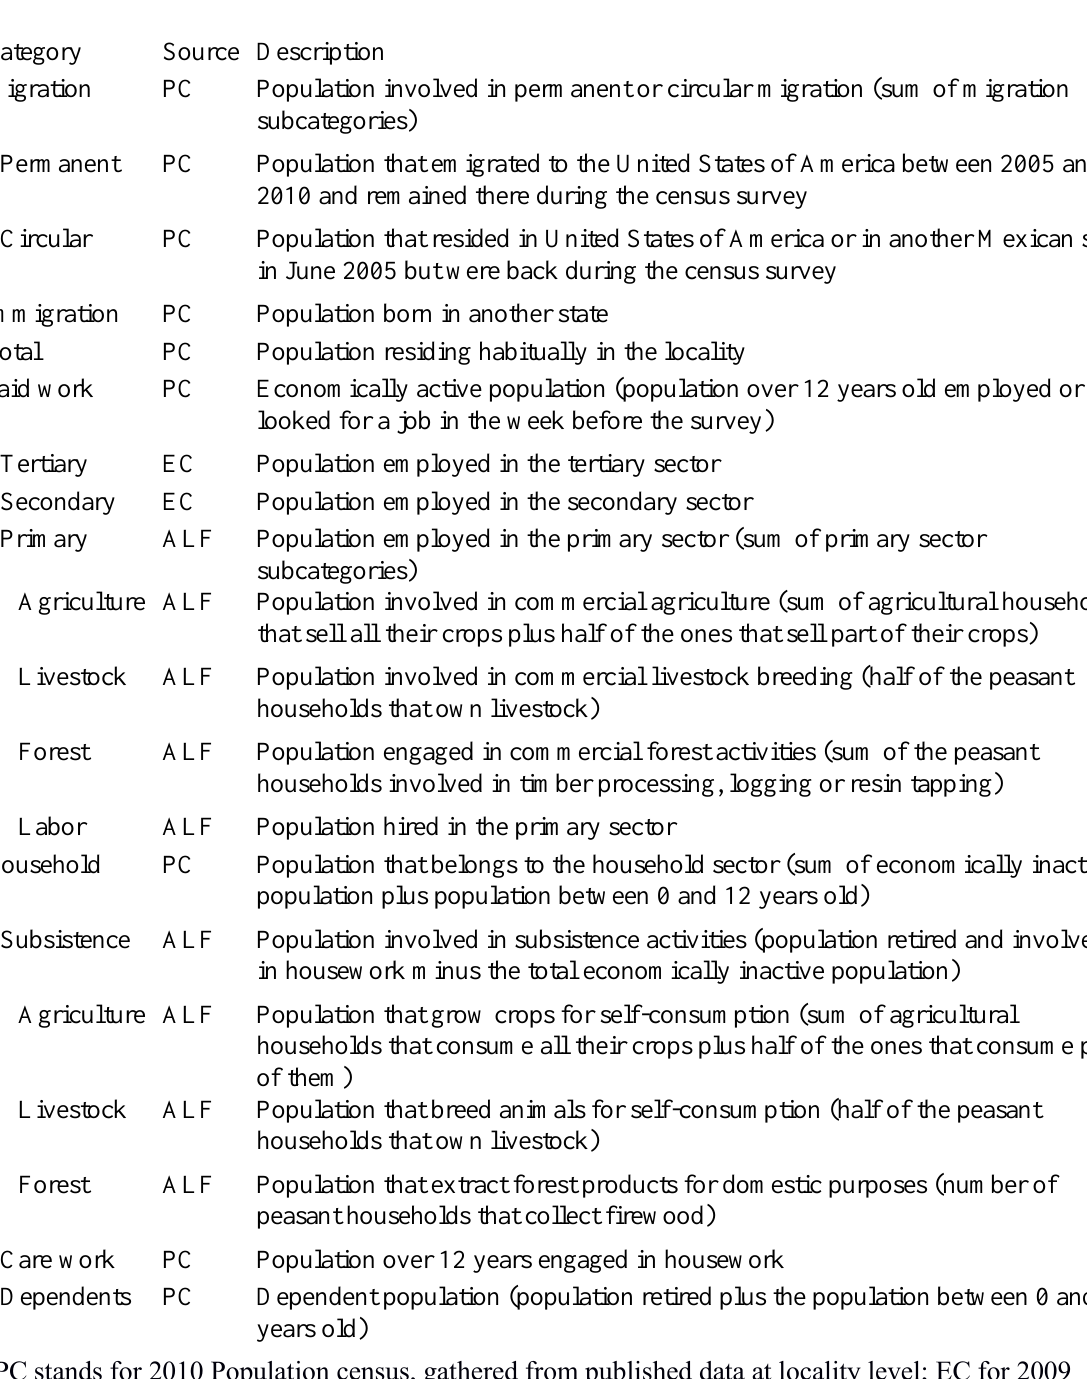
Table A1.2. Variables used for characterizing population in relational analyses